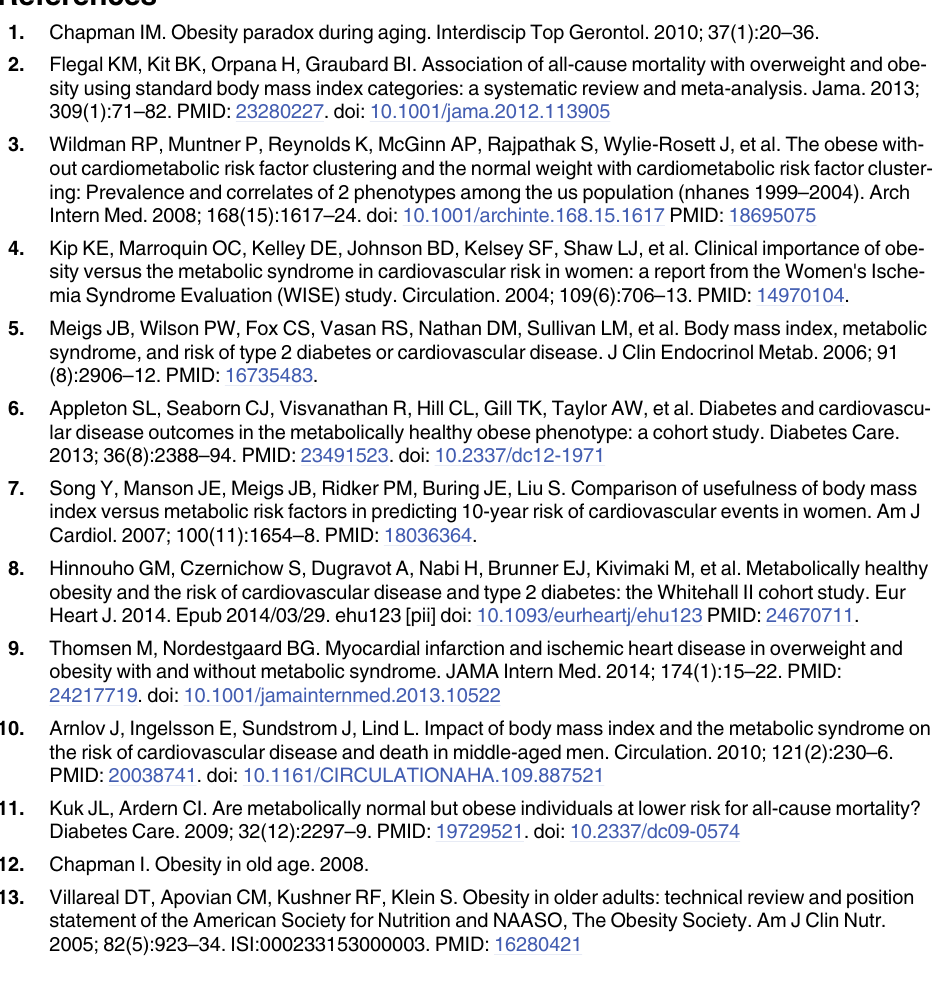
S5 Table. Associations of one, two, three, four, or five components of the metabolic syn- drome with cardiovascular disease. Hazard ratios and 95%confidence intervals are presented for the multivariable model adjusted for age, gender, smoking, cholesterol, treatment for hyper- lipidemia, estimated glomerular filtration rate (GFR), alcohol, physical activity, and education.